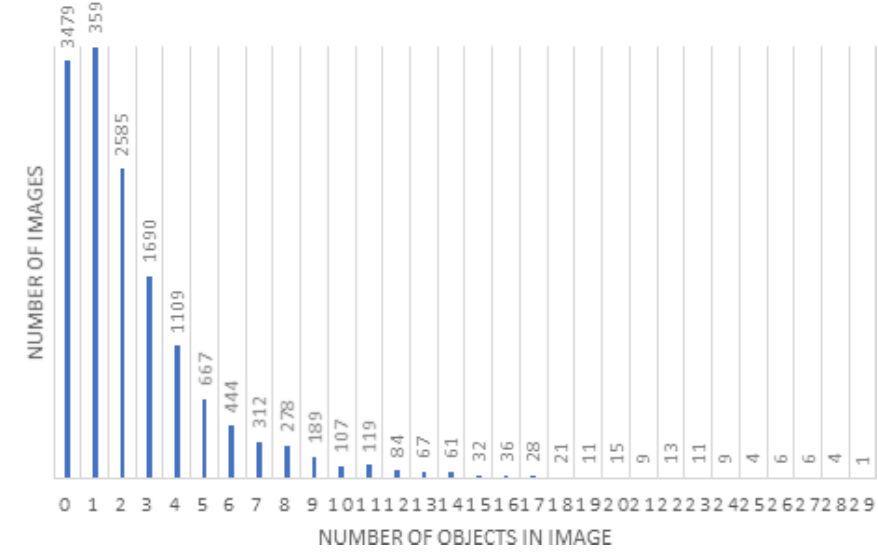
Figure 4. Average distribution of objects in images – data set with 15000